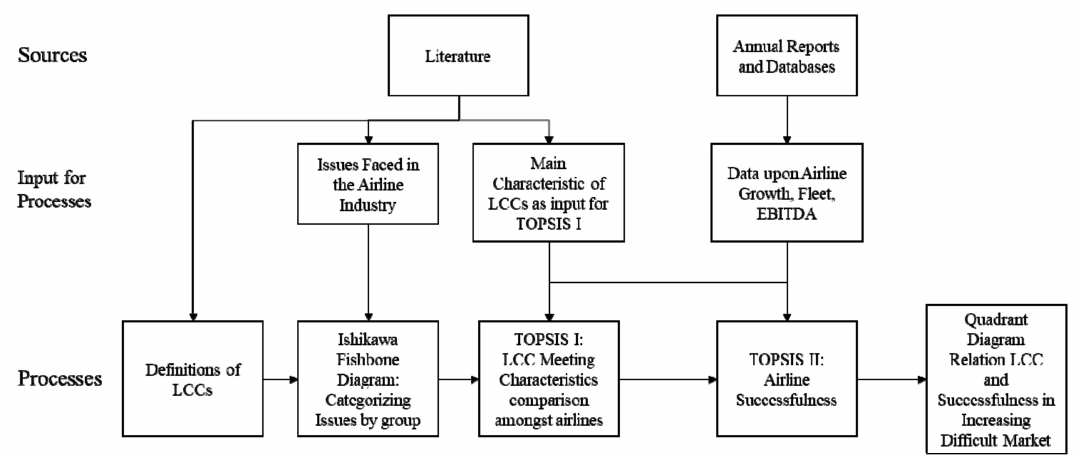
Figure 2. Diagram of research structure. Compiled by the